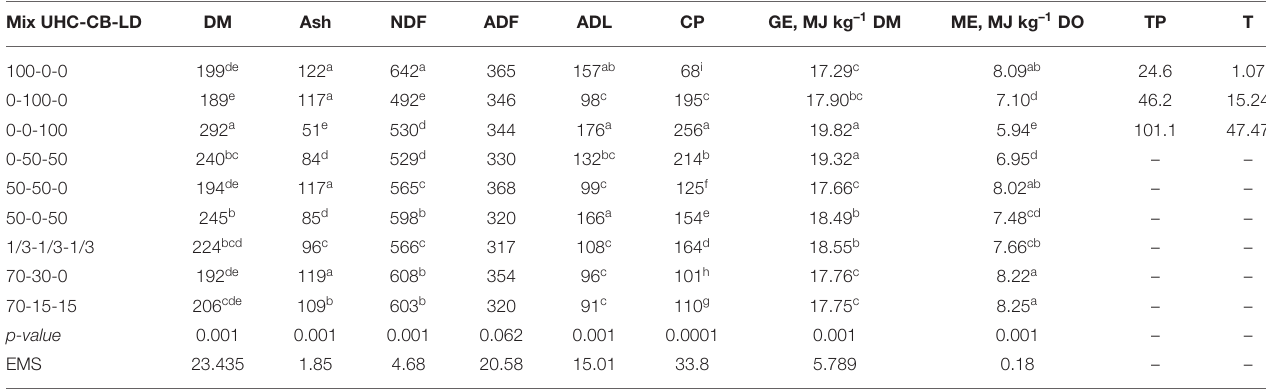
TABLE 1 | Mean chemical composition of Urochloa hybrid grass cv. Cayman (UHC) and the two forage legumes, C. brasiliensis (CB) and L. diversifolia (LD), and their mixed proportions used in the study. Mix UHC-CB-LD DM Ash